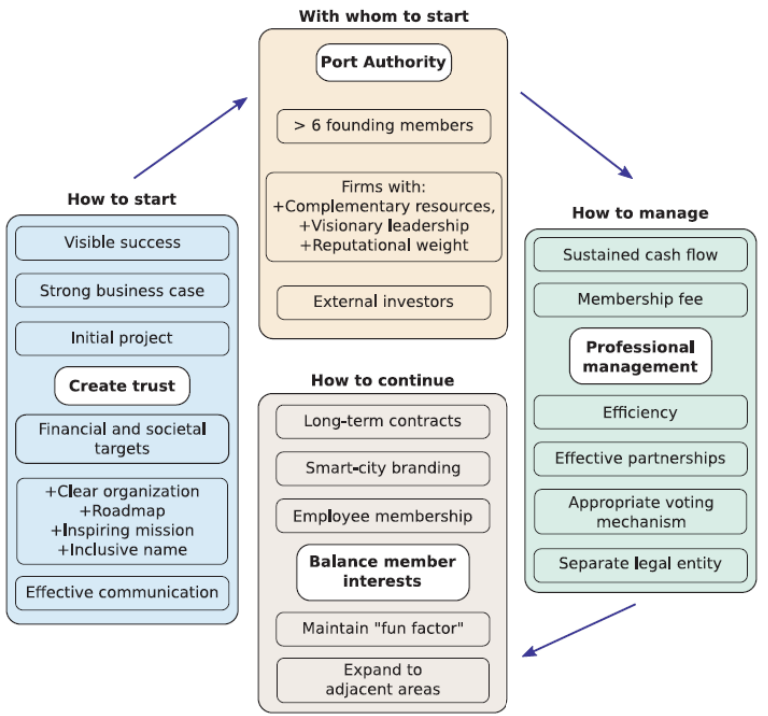
Figure 19. Action plan for launching a REC. Reprinted with permission from ref. [95]. Copyright © 2018 Elsevier Ltd. All rights reserved.